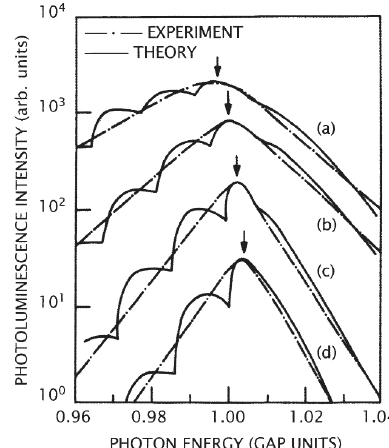
Figure 5. The theoretical and experimental luminescence spectra of CdS for increasing, from (d) to (a), laser-pumping power: (a) κ = 0.96, T * = 1790 K, (b) κ = 0.64, T * = 680K, (c) κ = 0.48, T * = 295K, (d) κ = 0.32, T * = 170 K. Parameter κ is the Fermi wave number multiplied by r , the electron spacing in units of the s excitonic Bohr radius. The arrow indicates the position of the peak value (Meneses 59